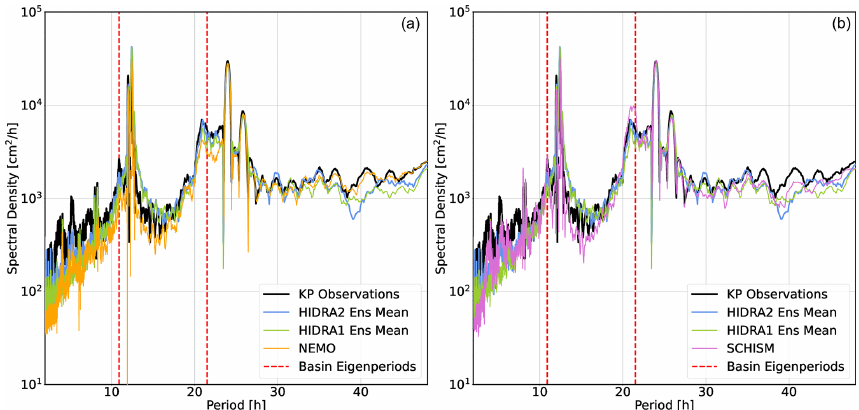
Figure 11. Spectral density of SSH time series from the Koper tide gauge, HIDRA2, and HIDRA1 compared with NEMO (a) and SCHISM (b) during independent cross-validation time windows between 1 June 2019 and 31 December 2020. Sharp peaks at (roughly) 12 and 24h indicate the presence of tides, while the two dashed vertical red lines mark the periods of the two lowest Adriatic sea level eigenmodes. For clarity, all plotted spectral densities were filtered using a third-order Savitzky–Golay 24-point window filter.